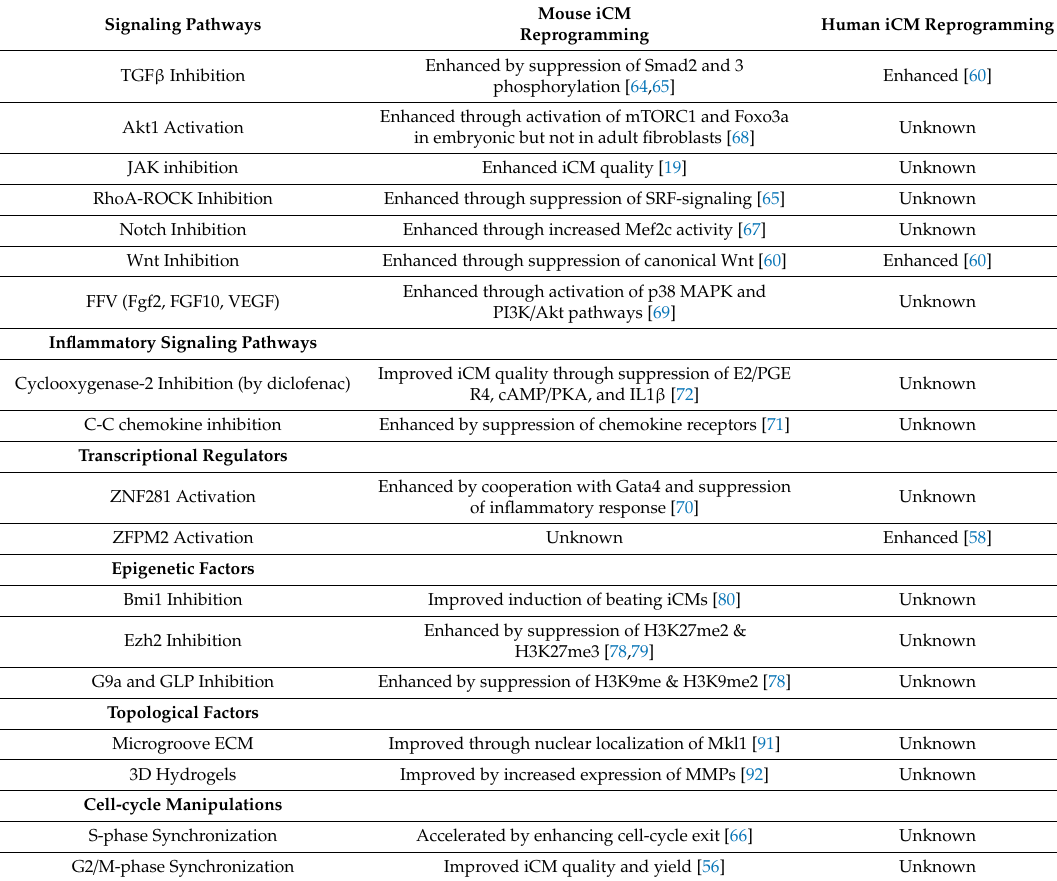
Table 1. A summary of the mechanistic understanding of recent publications on mouse and human iCM